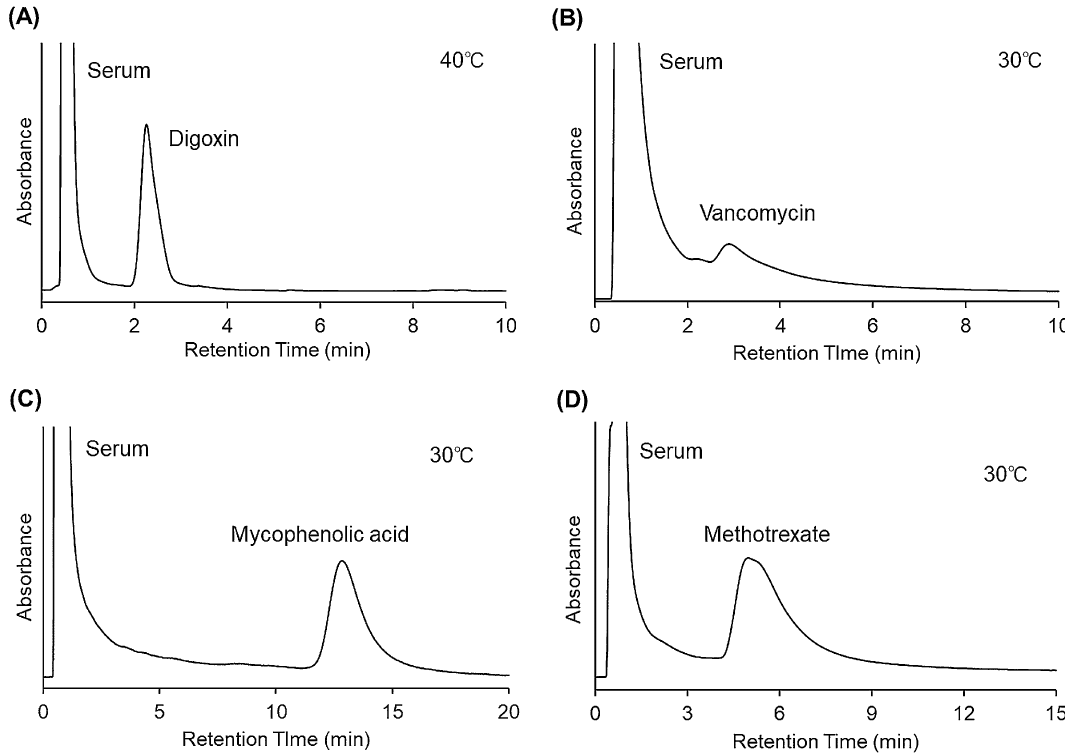
Figure 8. Chromatograms of ( A ) digoxin, ( B ) vancomycin, ( C ) mycophenolic acid, and ( D ) methotrexate in serum using crosslinked PNIPAAm modified-bead packed columns. The mobile phase was 10 mM CH 3 COONH 4 buffer solution (pH 6.75) for digoxin, and 10 mM CH 3 COONH 4 buffer solution (pH 4.80) for vancomycin, mycophenolic acid, and methotrexate. The mobile phase flow rate was 1.0